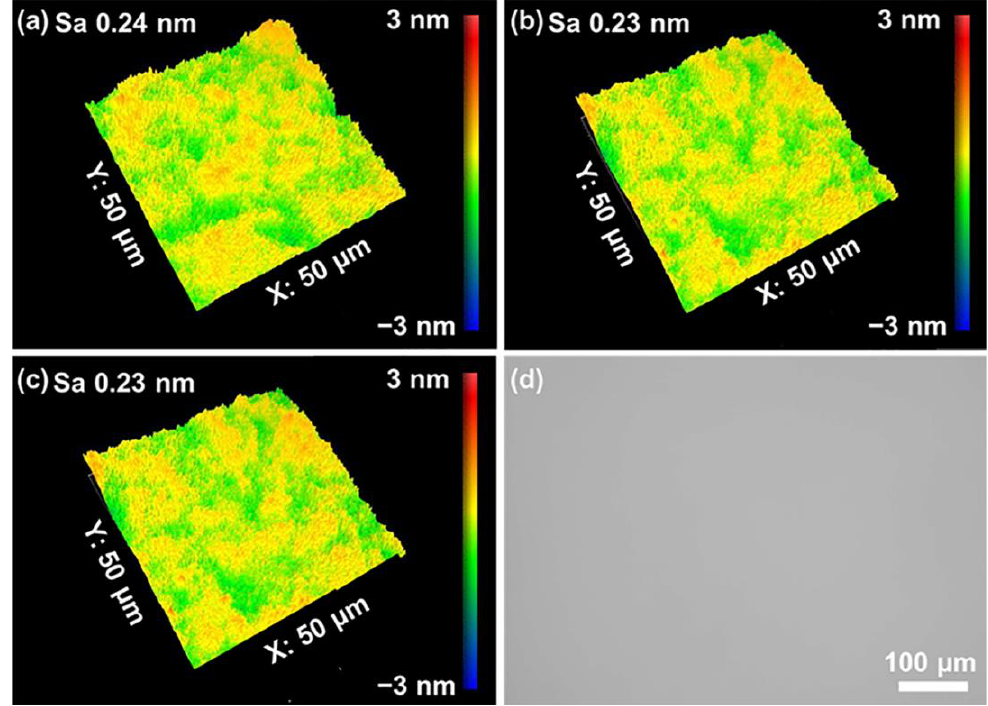
Figure 5. (a), (b), (c) The surface morphology and surface roughness on three random spots; and Figure 5. ( a – c ) The surface morphology and surface roughness on three random spots; and ( d ) an (d) an optical image of the polished sample. optical image of the polished